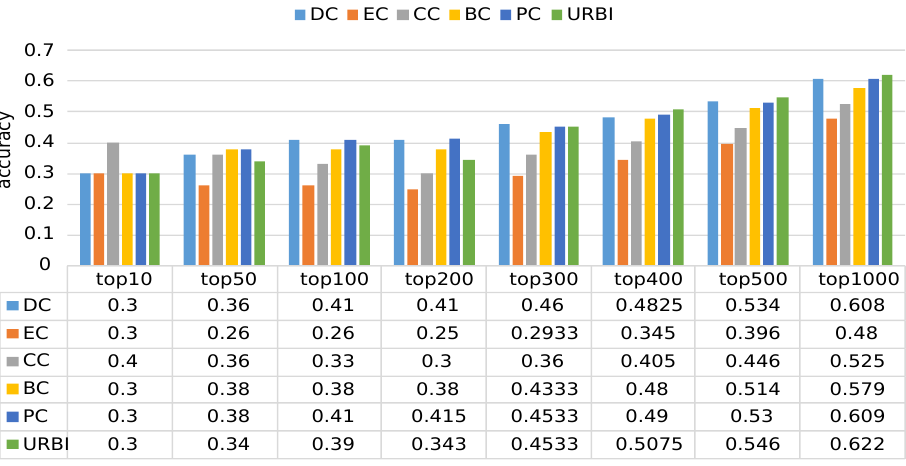
Figure 3. This figure depicts the experimental results of dataset No.3, which contains 6647 book